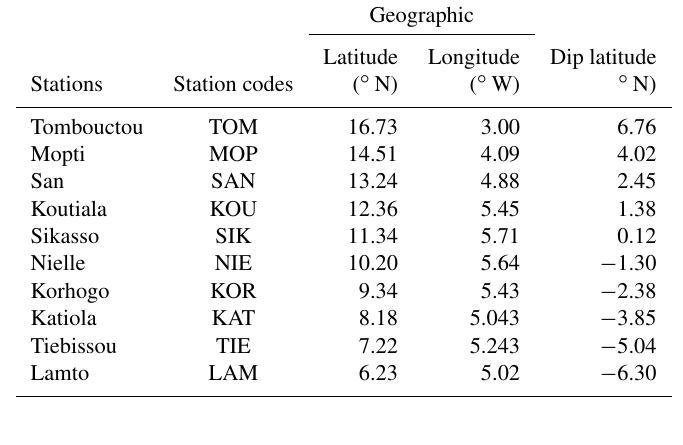
Table 1. Geographic coordinates of the magnetic stations installed along the meridian 5 ◦ W in West Africa during the International Equatorial Electrojet Year.